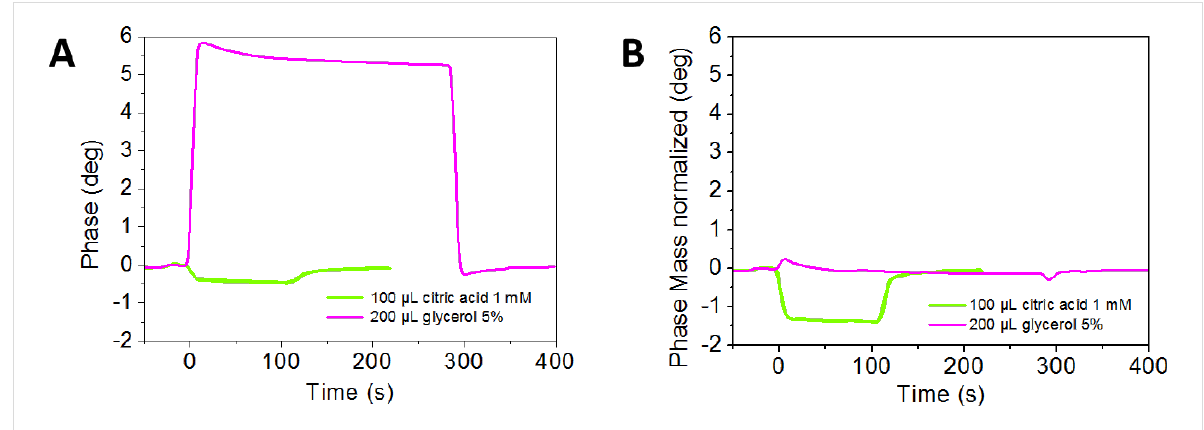
Figure 5: Comparison between the original phase signal and calculated mass normalized phase signal. The time-courses of all signals are aligned according to the injection start. The green lines represent an overlay of 4 citric acid injections as indicated in Figure 4. Note that these signals are extremely reproducible. The line in magenta represents the glycerol injection. (A), original phase signal; (B), calculated mass normalized phase signal. The glycerol signal in (A) was used for the software-automated calculation of all signals shown in (B).